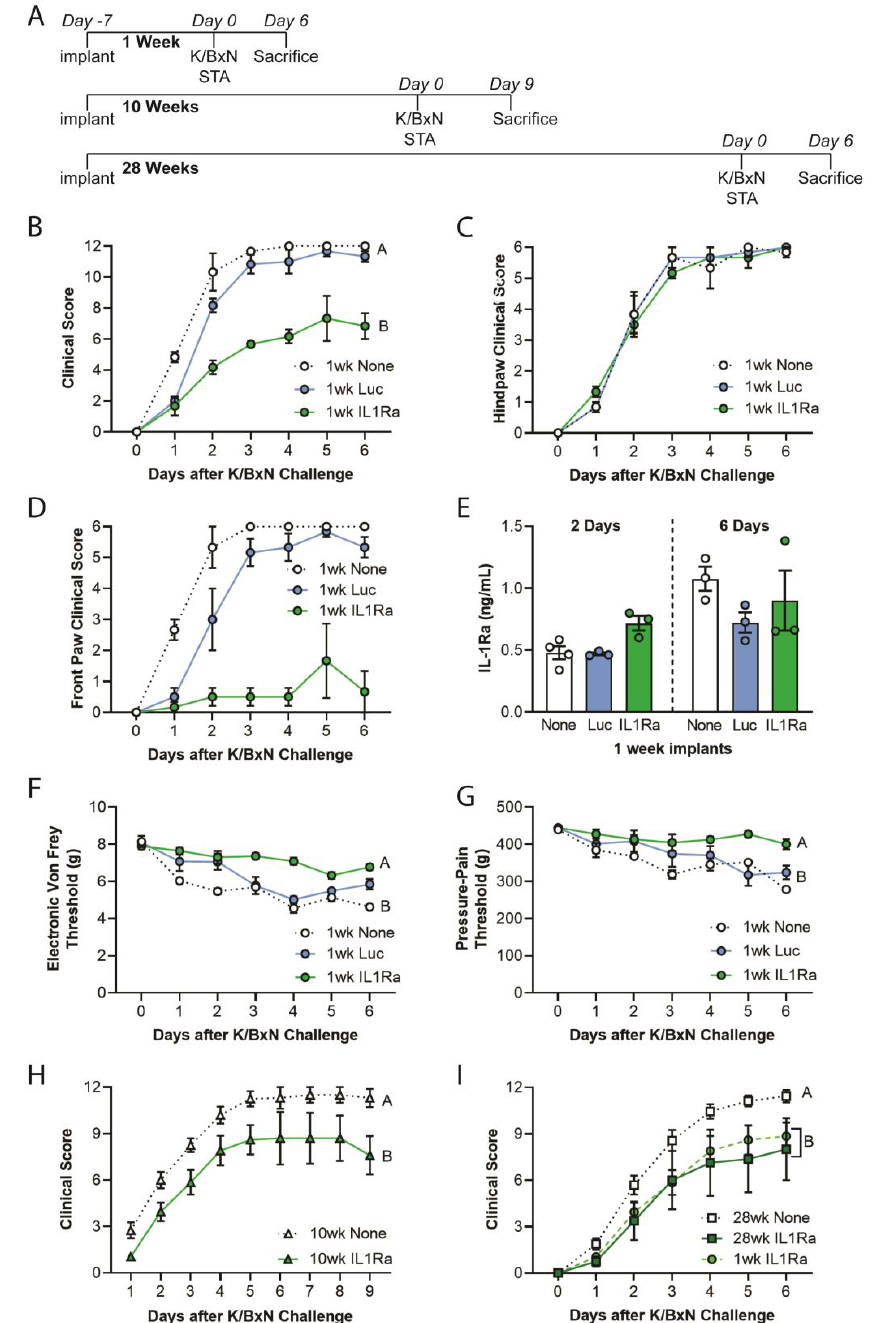
Figure 4. ( A ) Timeline showing in vivo K/BxN serum transfer arthritis (STA) studies at 1 week, 10 weeks, or 28 weeks post-subcutaneous implantation of Ccl2-IL1Ra agarose rods. Clinical scores of K/BxN STA animals 1 week after implantation of Ccl2-luc or Ccl2-IL1Ra agarose rods over 6 days of observation for ( B ) overall clinical scores, ( C ) hindpaws and ( D ) front paws. ( E ) IL-1Ra levels in serum at day 2 post K/BxN serum challenge, as measured by ELISA. IL1Ra constructs significantly mitigated mechanical allodynia by ( F ) Electronic von Frey and ( G ) pressure-pain hyperalgesia. STA overall clinical scores ( H ) 10 weeks and ( I ) 28 weeks after implantation of Ccl2-IL1Ra agarose rods. Note that the degree of disease mitigation observed after 28 weeks is similar to mitigation 1 week after implantation. Different letters indicate significant main effects of group, p < 0.05. N = 3–6/group, data were analyzed by 2-way repeated measures ANOVA with Dunnet’s or Tukey’s post-hoc test. Different letters indicate main effect of group p <